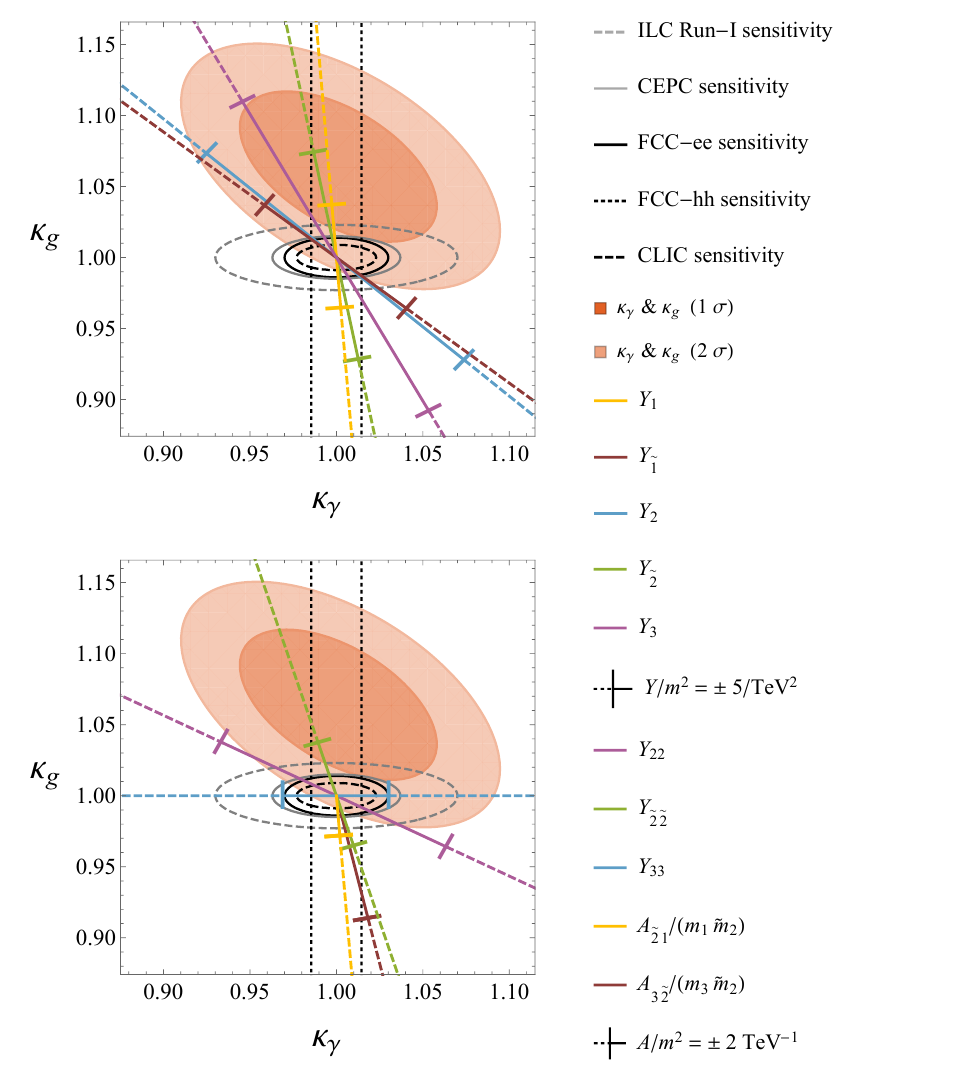
Figure 6. Correlations between κ γ and κ g for the different Lagrangian parameters. Here we assumed all bi-linear LQ mass terms to be equal. Here we used one degree of freedom in the χ 2 fit for the allowed regions and the future prospects such that the intersection with the LQ line indicates the 68% and 95% CL for the corresponding parameter Y/m 2 or A 2 /m 4